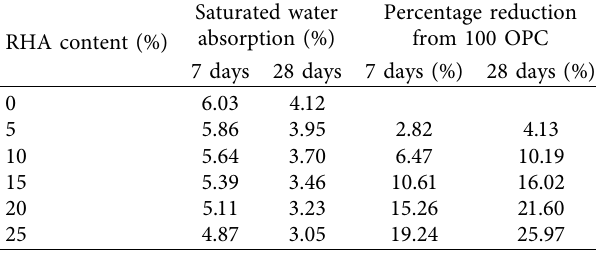
Table 12: Water absorption of RHA concrete [59].